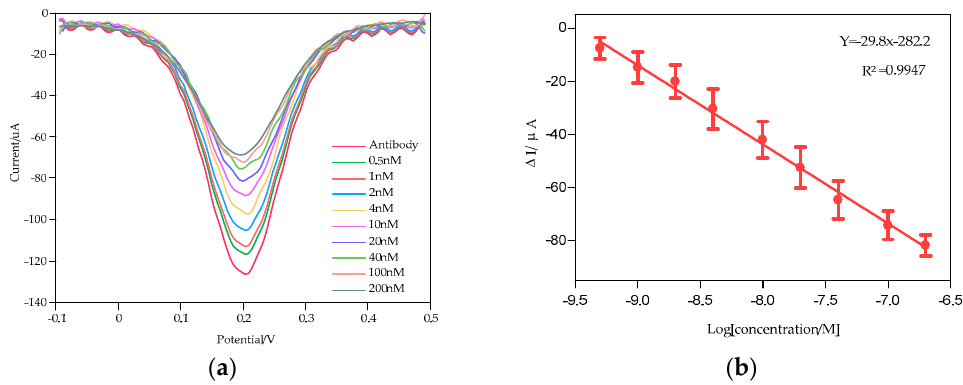
Figure 5. Electrochemical detection of cortisol using smartphone-controlled DPV system. ( a ) DPV responses of cortisol from 0.5 nM to 200 nM, ( b ) calibration curve for cortisol immunosensor.